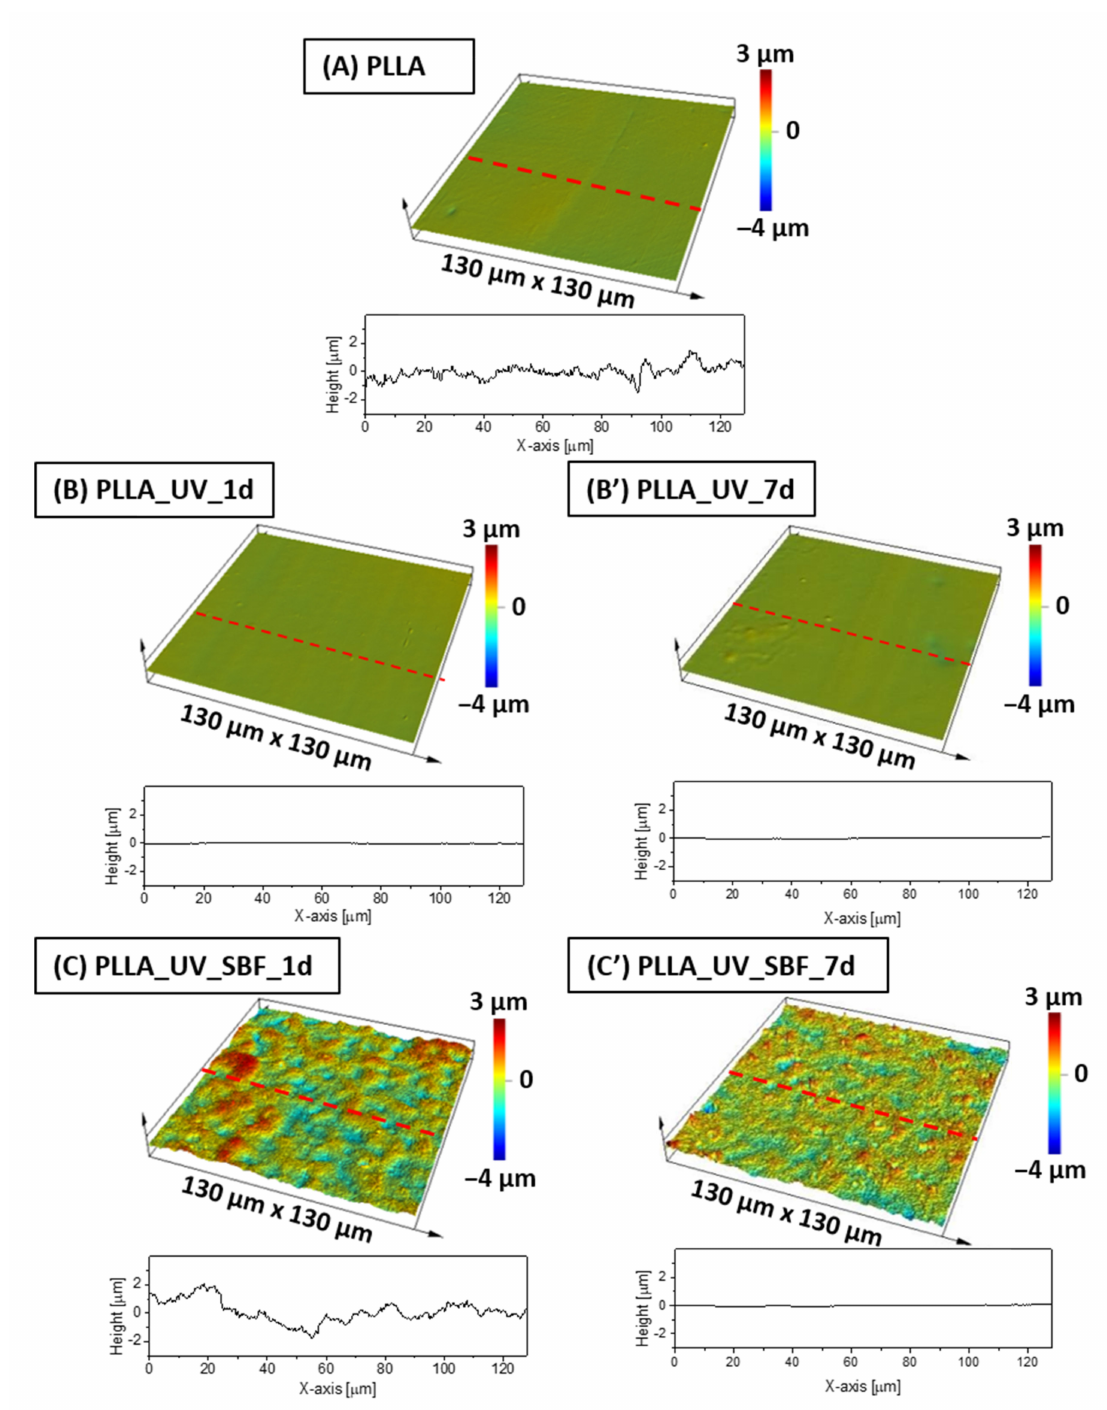
Figure 2. Surface profiles for ( A ) PLLA reference sample, ( B , B (cid:48) ) PLLA after laser activation, ( C , C (cid:48) ) PLLA after laser activation and incubation in